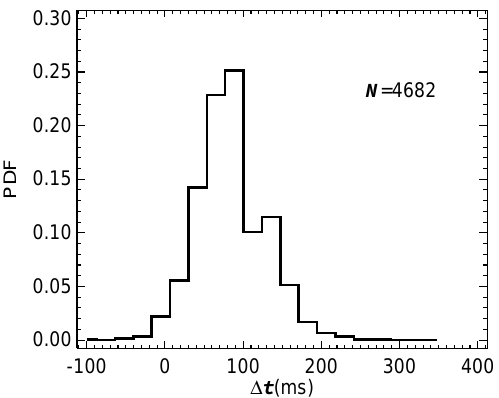
Fig. 5. Normalized frequency bandwidth 1f/f c e as a function of the Z S M coordinate for the 4682 analyzed wave packets recorded by the four Cluster spacecraft in the chorus source